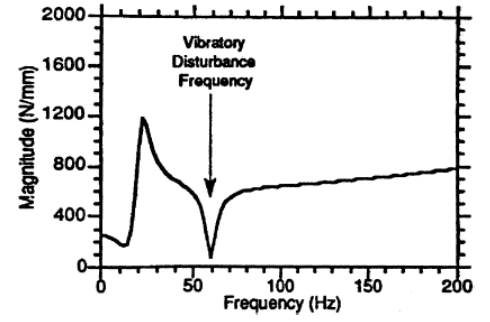
Fig. 10. Dynamic stiffness of the active hydraulic mount [31].